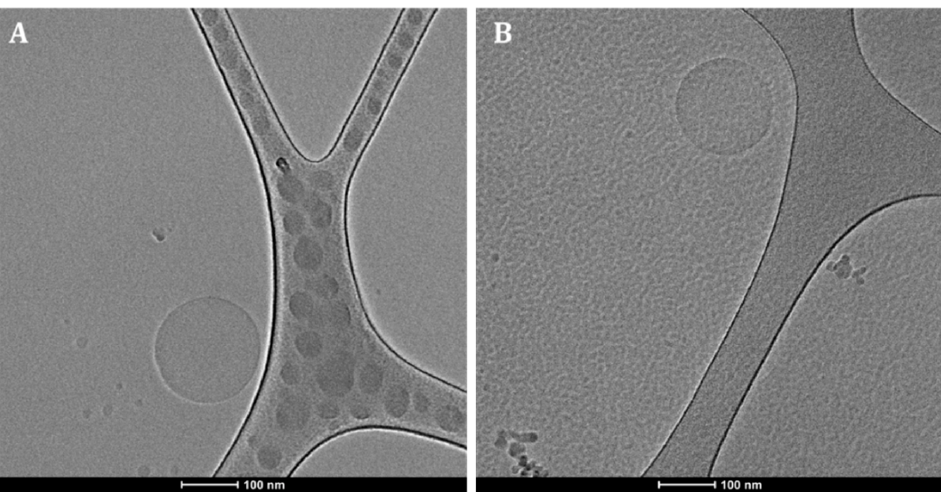
Figure 6. Analysis of the morphology of NPs by Cryo-TEM. Cryo-TEM images of ( A ) 0.6:1 CTX: SA-PEG NPs; and ( B ) NLCs not encapsulating a drug, in water. The scale bars denote 100 nm. Note that the CryoTEM images only show examples of the morphology of typical NPs. For size statistics, please refer to the DLS data.